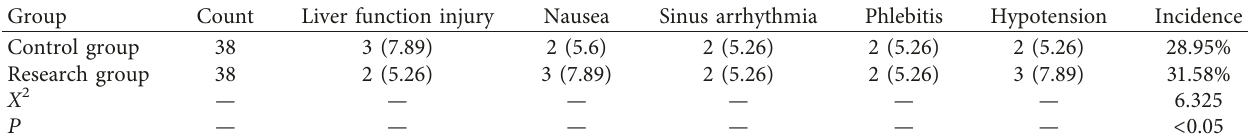
Table 3: Analysis of two groups of